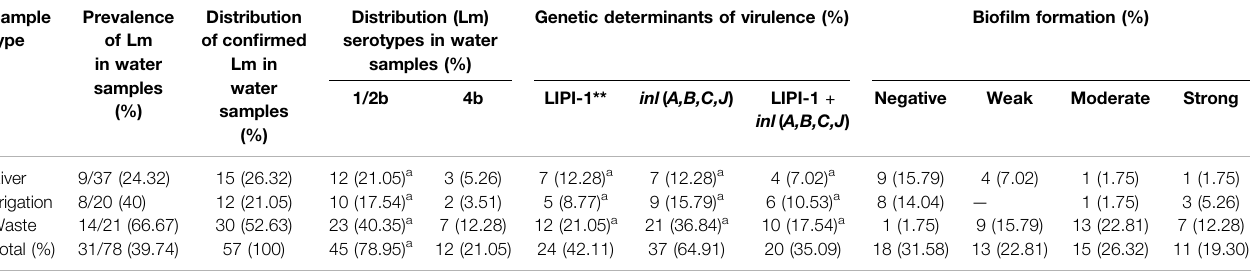
(LIPI-1) isolates harboring all LIPI-1 virulence genes. inl (A, B, C, J) isolates harboring all the internalin genes. LIPI-1 + inl (A, B, C, and J) isolates harboring all the LIPI and the internalin genes. a Association between serotype and genetic/determinants of virulence.